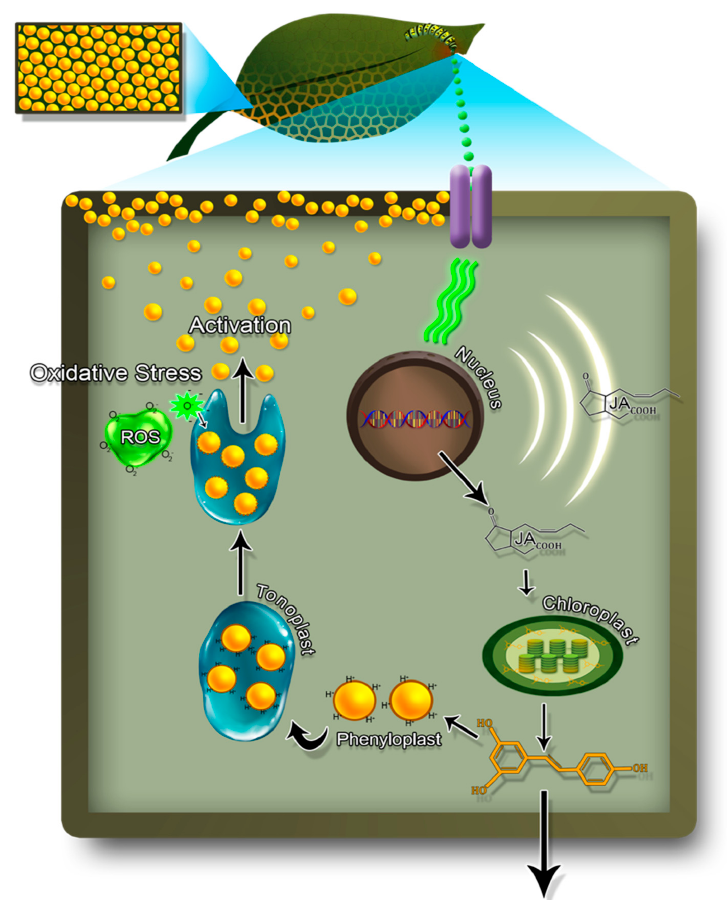
Figure 3. Schematic representation of signaling cascade after insect herbivory at the cellular level inside a plant cell. The regurgitant of caterpillar that includes contents from salivary gland and gut consists of fatty acid conjugates, β -glucose oxidase, peroxidase that acts as elicitors. Elicitors binds with the receptors on cell membrane and cause biochemical changes in the cell culminating in gene expression and the activation of octa-decanoid pathway [117] which upregulates defense- related genes followed by down-regulation of photosynthesis genes. The upregulation of defense genes that encodes proteins can be broadly classified into three categories- defense genes which produce anti-nutritional proteins and the enzymes involved in shikimate-phenylpropanoid pathway producing secondary metabolites, proteinase inhibitors which are involved in cross-linking and polymerization of cell walls and the third includes phytohormone signaling pathway genes for i.e., jasmonic acid, salicylic acid and ethylene. Jasmonic acid moves to plastid/chloroplast to activate the chief enzyme of shikimate pathway i.e., phenylalanine ammonia lyase (PAL). Most of the polyphenol biosynthesis takes place in plastids, however flavonoid production occurs either in the cytoplasm or the cytoplasmic surface of endoplasmic reticulum [127]. PAL in the stomata diverts amino acids from primary metabolism toward the formation of secondary metabolites including a diverse set of polyphenols via activation of a suite of defense genes [128]. Some polyphenols are shuttled outside the cell to act as anti-feedant or anti-deterrent to ward-off the herbivory, while others are stored inside the tonoplast of cells for quick-future action. These polyphenols are compartmentalized by converting them into inert and reduced state called phenyloplast, protected inside the tonoplast. During the successive herbivore attack, the regurgitant of herbivores that activates reactive oxygen species generates oxidative stress in the cell, leading to dissolution of compartments and release of polyphenol oxidase. Polyphenol oxidase can form quinones which act as anti-nutritional proteins interfering with digestibility and nutrient uptake of insects or produce proteinase-inhibitors leading to cross-linking and polymerization of cells leading to herbivore defense. Illustration by Annette Diaz, conceptualized by Ishveen Kaur and Japneet